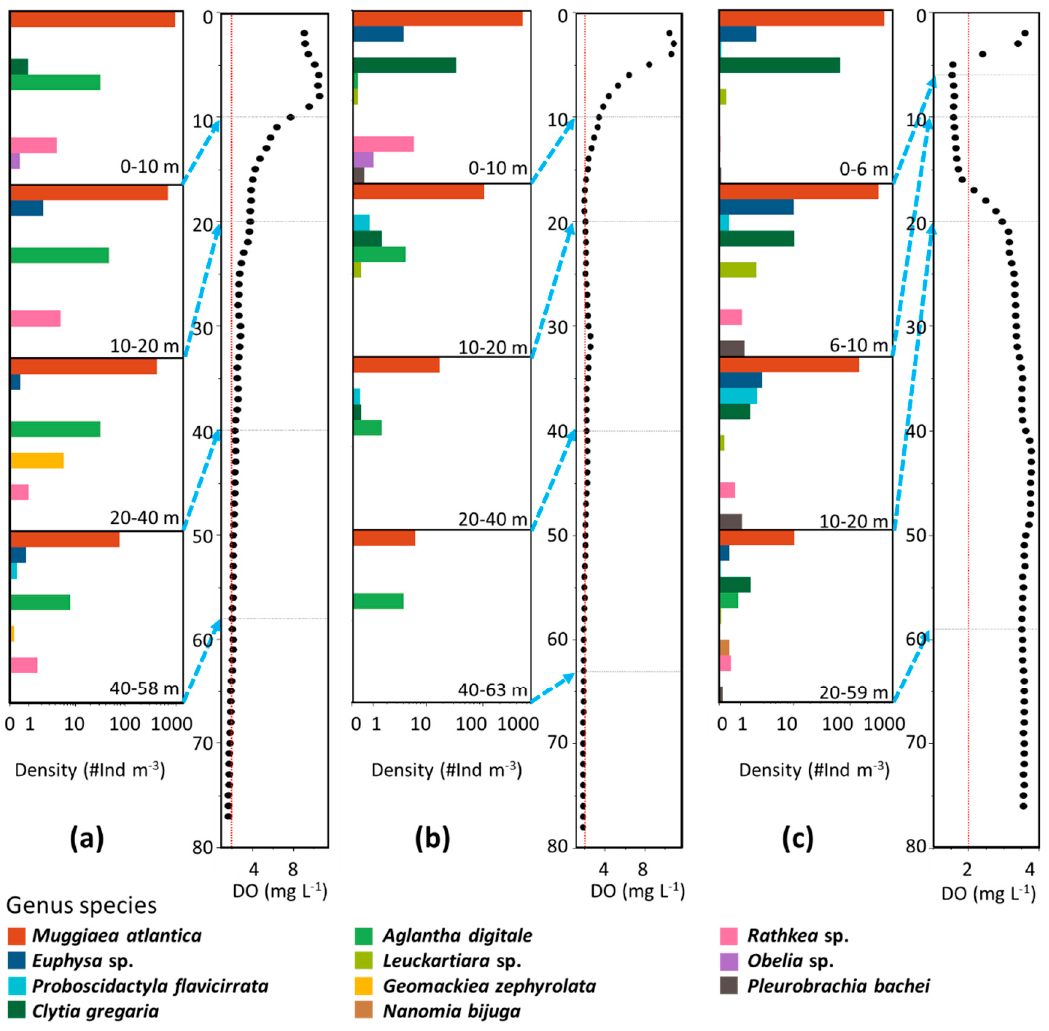
Figure 7. Daytime vertical distributions of mesoplankton jellyfish (Ind m − 3 ) during hypoxic events at Union in ( a ) August, ( b ) September, and ( c ) October 2013 with corresponding CTD profiles of dissolved oxygen (mg L − 1 ). Depth range sampled by each net is indicated in panels using horizontal grey lines and blue dashed arrows. Vertical red lines indicate 2 mg L − 1 dissolved oxygen. Note that hypoxic water was present in deep water in August and September, but near surface in October. Note the log scaling of densities.